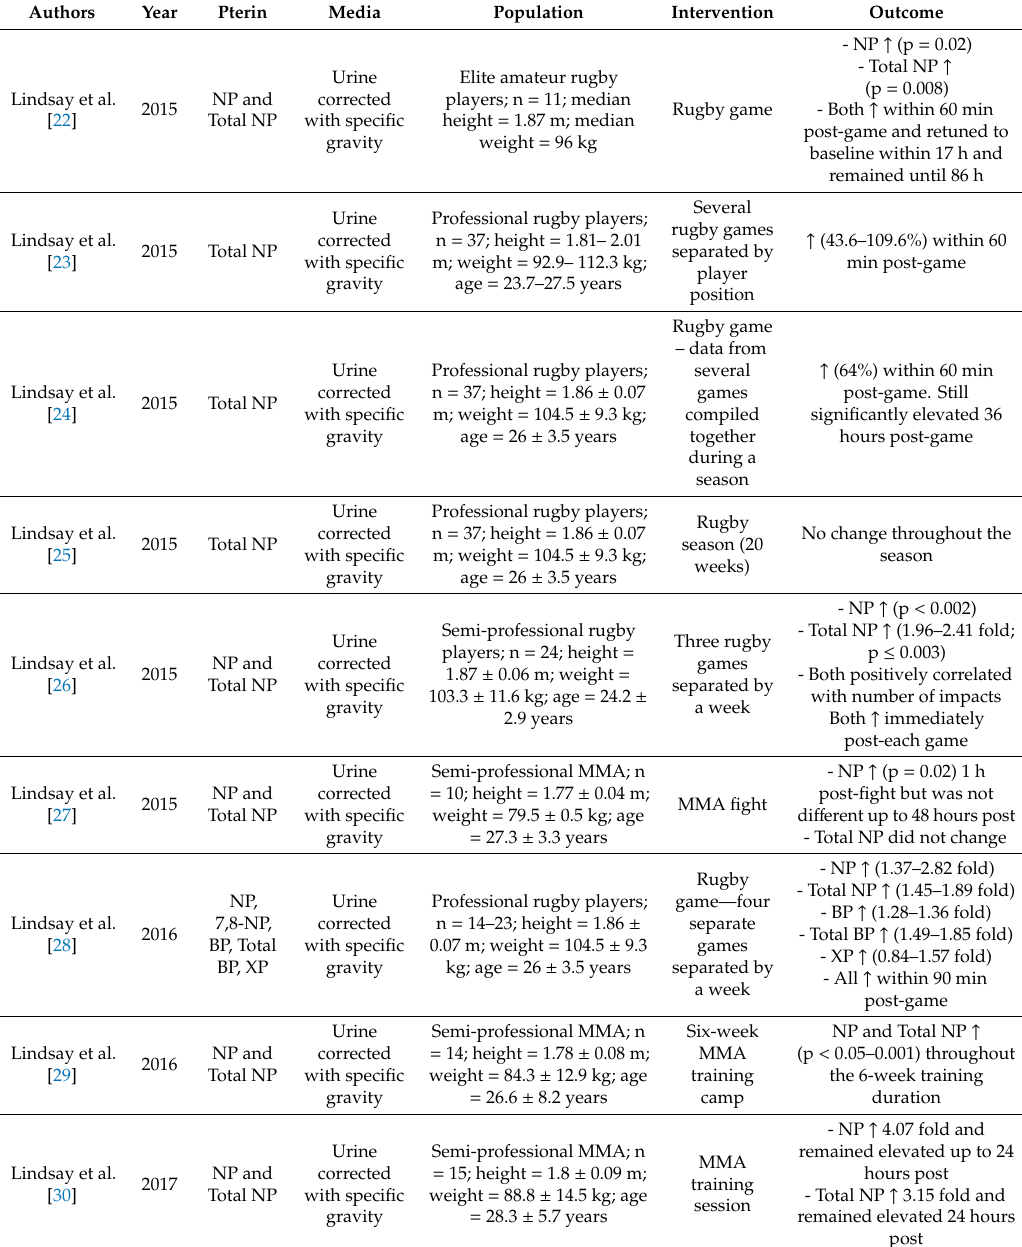
Table 1. Studies measuring pterins following impact-induced trauma in exercise and